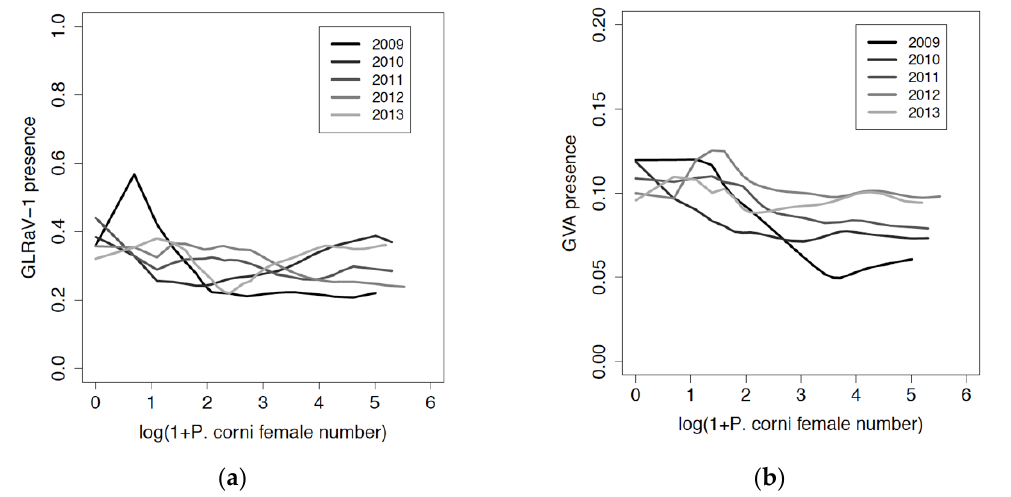
Figure 8. Relation between virus presence in 2009 – 2014 in vines and female numbers of Parthenolecanium corni from 2009 to 2013. ( a ) GLRaV-1, ( b ) GVA. x -axis: population density expressed as log (1 + P corni female number). y -axis: estimated probability of virus presence .